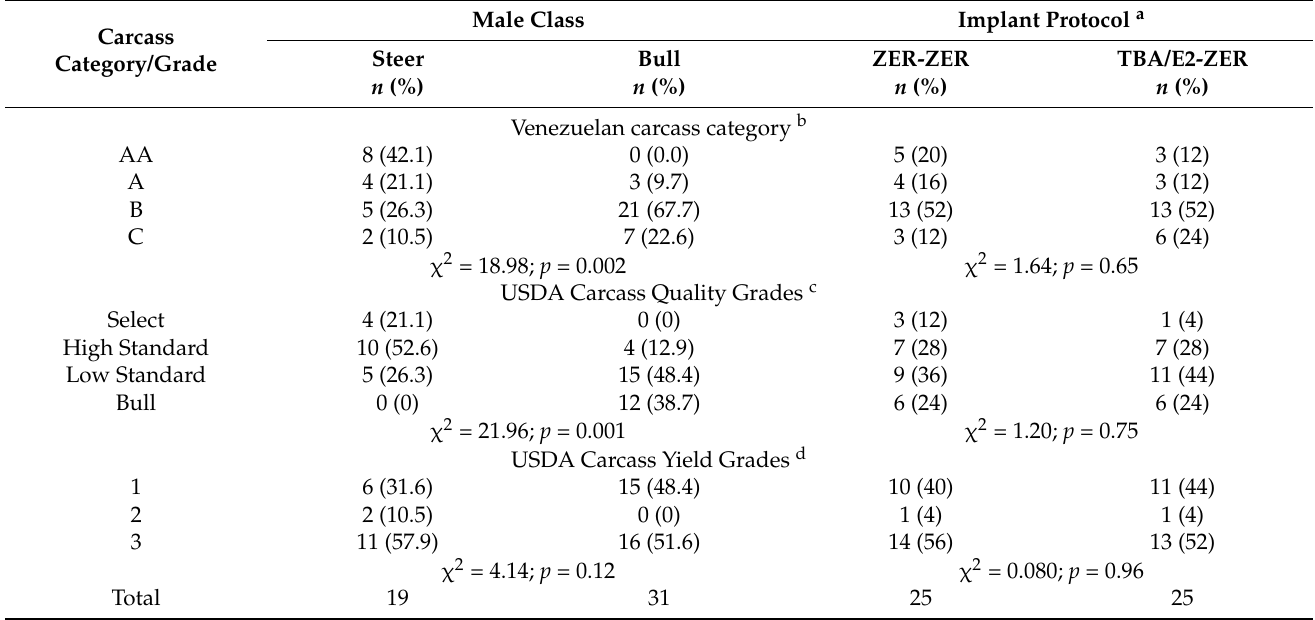
Table 8. Frequency distribution of carcass categories/grades according to male class and implant protocol (Experiment II).